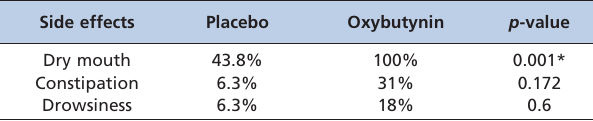
Table 5 - The presence of side effects in the placebo and oxybutynin